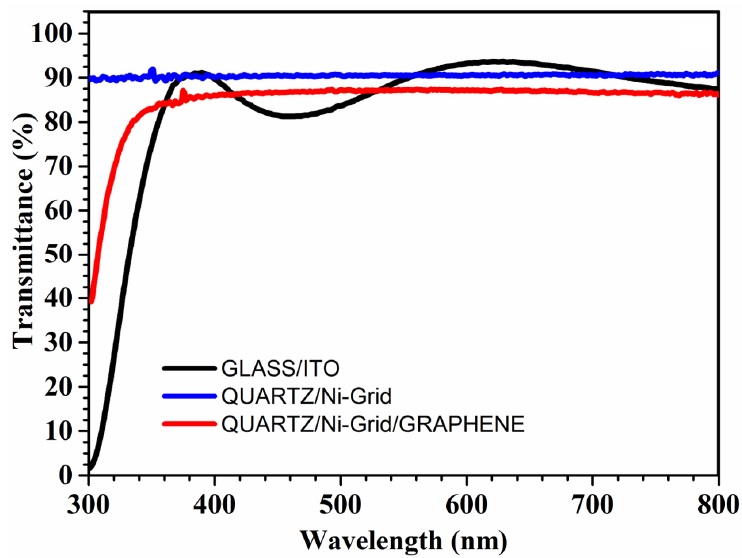
Figure 4. Optical transmission spectra, in the visible range, of quartz/Ni-grid ( blue line ) and quartz/Ni-grid/graphene ( red line ). For comparison the spectrum of ITO on glass is also included. The optimized graphene/Ni-grid geometry was then used as an electrode in OSCs: three different thicknesses of the grids, 20 nm, 40 nm and 80 nm were tested for the direct architecture, while the 40 nm thick grid, which was giving the best performances on the direct architecture, was chosen for the inverted one. The produced devices were compared with identical ones fabricated on glass/ITO, on bare Ni grids on quartz and monolayer graphene (MLG) on glass for both architectures. The measures on the MLG/Ni-grids have been performed on eight samples of each type, the resulting statistics are reported in Figure 5 for both architectures.